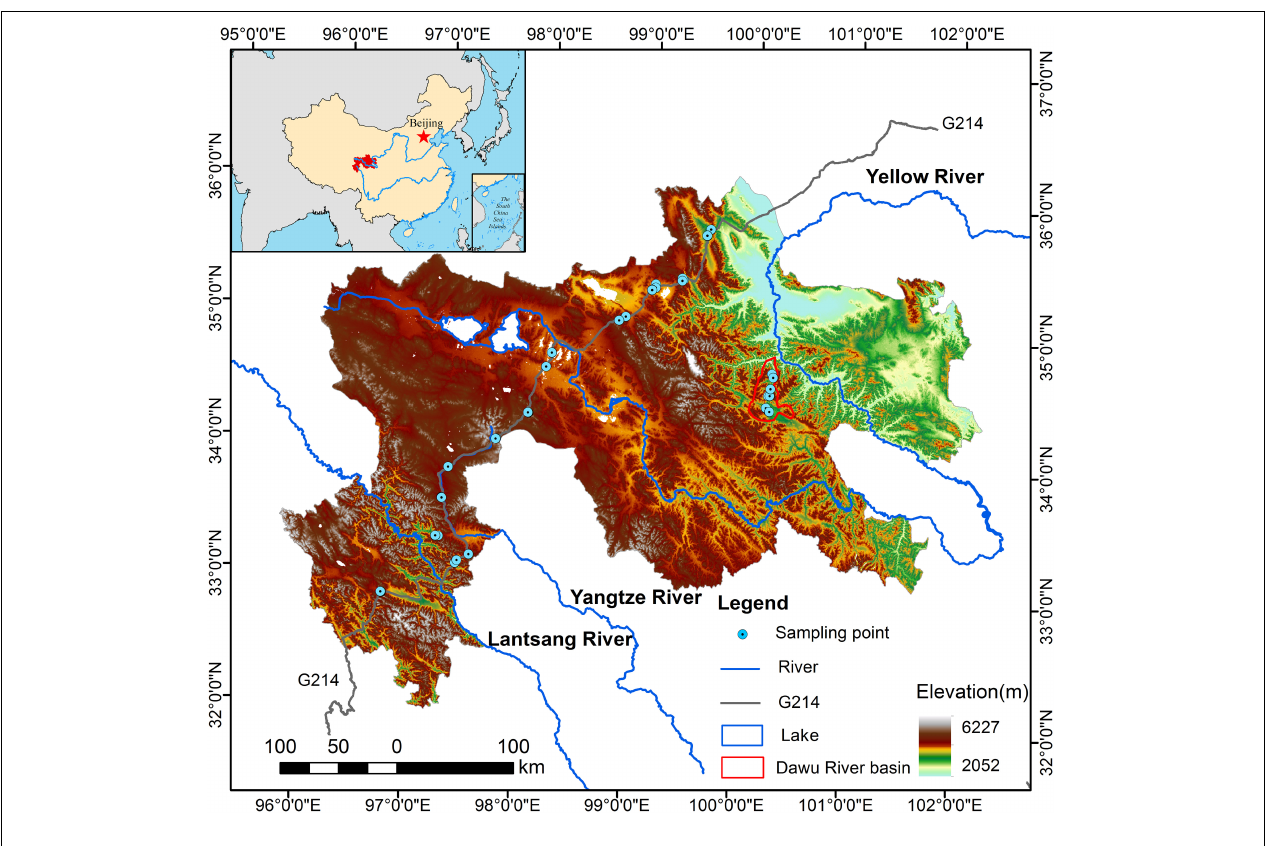
FIGURE 1 | Map of study area and sampling points.